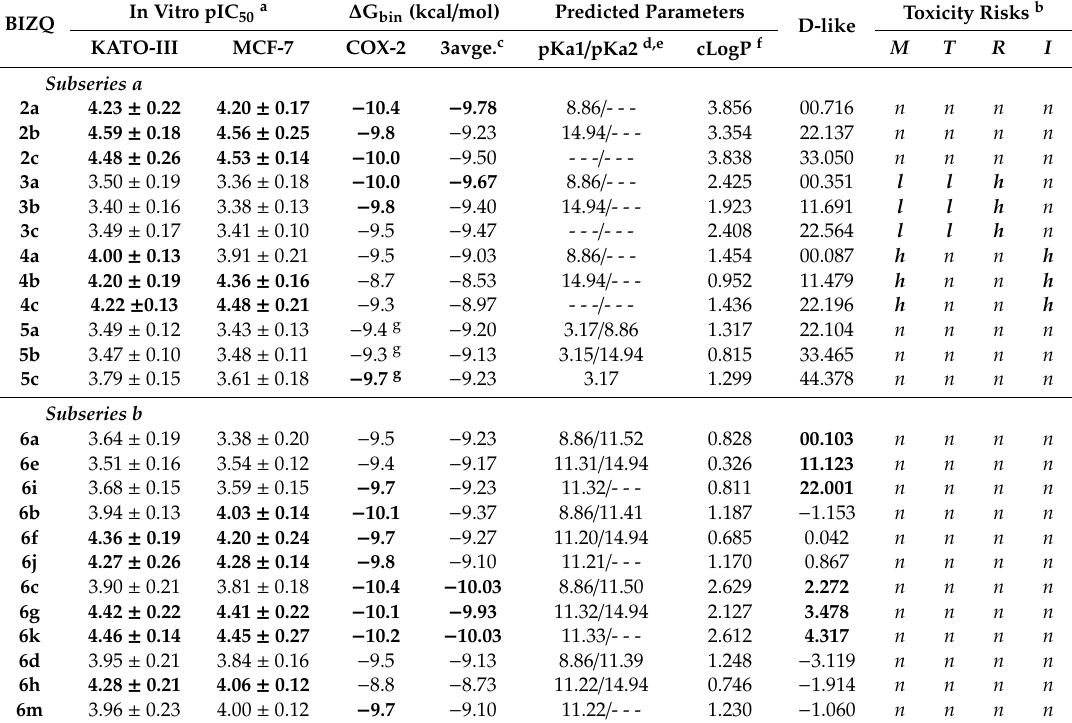
Table 3. In vitro cytotoxicity results on KATO-III and MCF-7 cells, calculated binding energies, physicochemical parameters, drug-likeness scores, and potential toxicity risks for BIZQs. In Vitro pIC 50 a ∆ G bin (kcal / mol) Predicted Parameters BIZQ